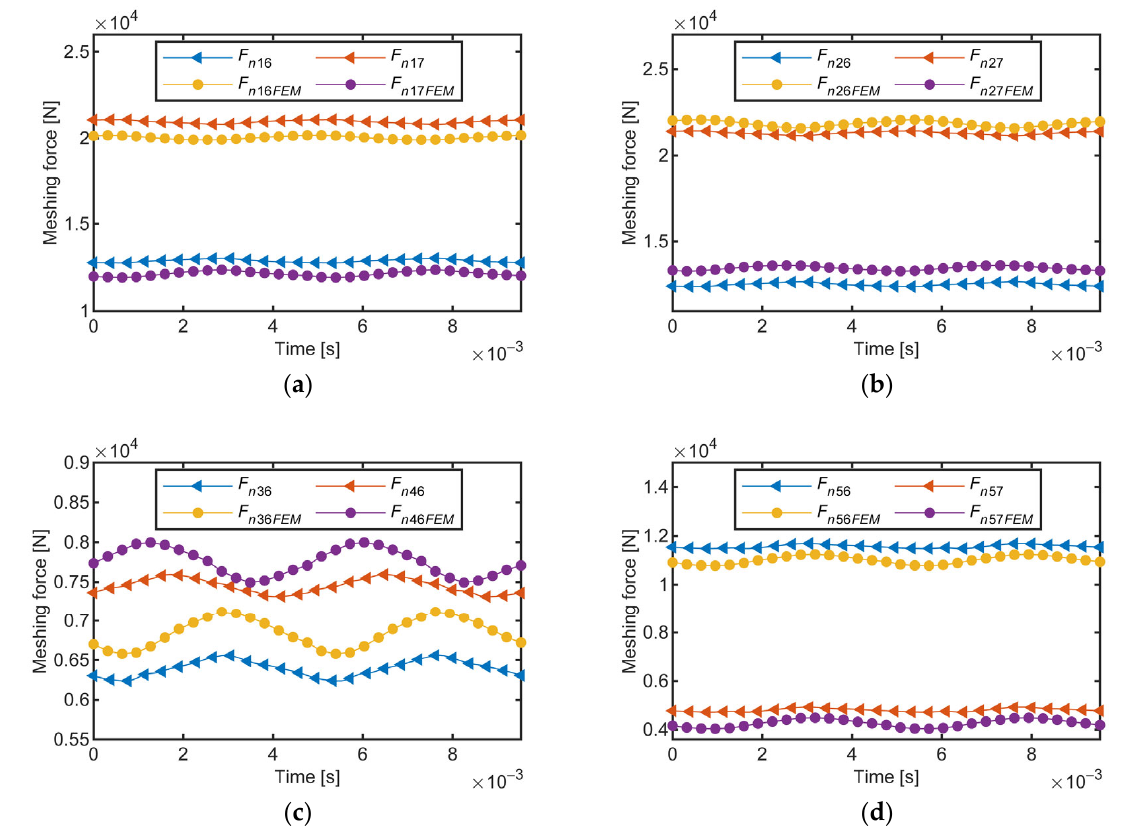
Figure 13. Comparison of meshing force between proposed model and finite element model: ( a ) Input Gear 1; ( b ) Input Gear 2; ( c ) idlers; ( d ) tail gear.